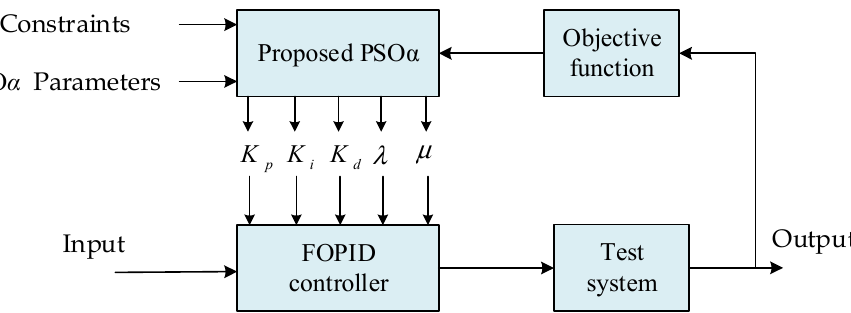
Figure 6. The methodology for the implementation of proposed PSO α optimisation techniques for LFC.